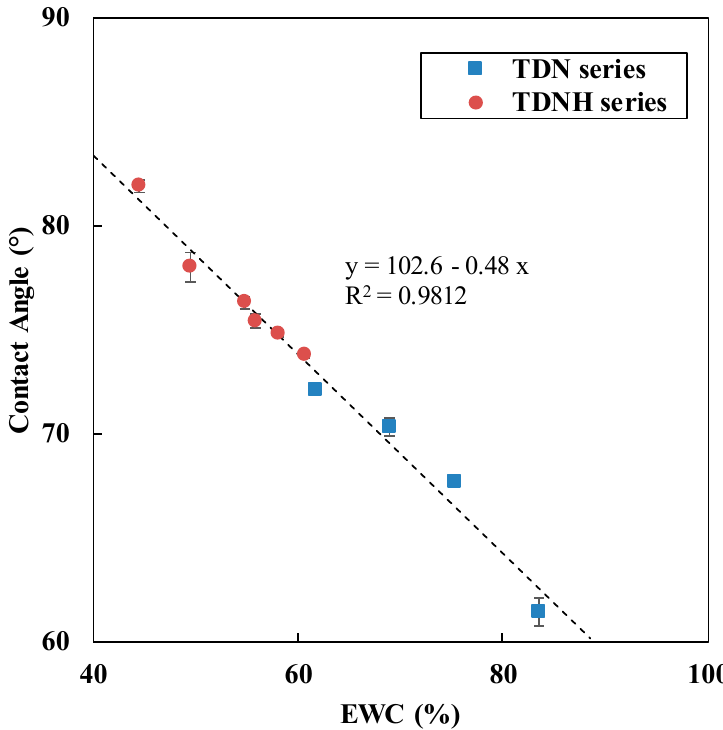
Figure 3. The correlation between EWC and contact angle for p(TRIS-DMA-NVP-HEMA).